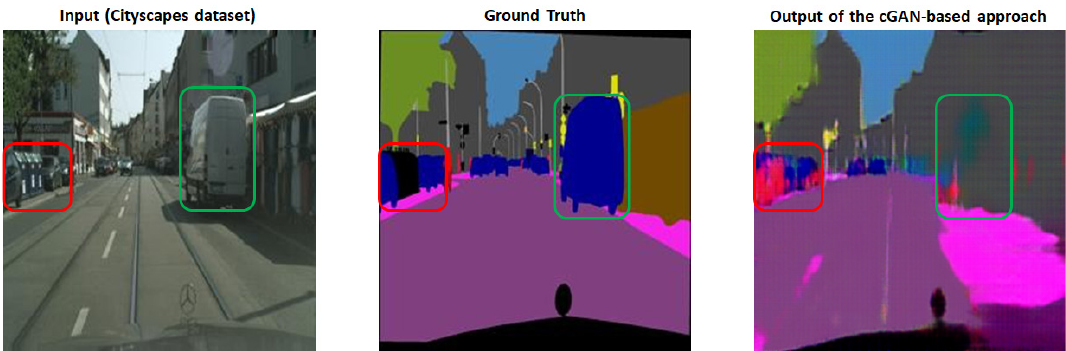
Figure 8. Evaluating the stability and accuracy of the GAN, where imbalanced training results in instability that affects the accuracy.